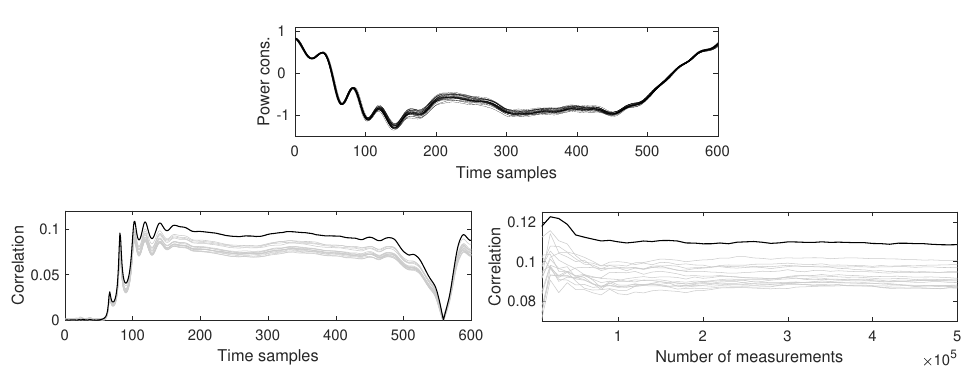
Figure 6: Overlay of 30 sample traces and a CPA attack using the Hamming distance of two first-round Sbox outputs based on consecutive known